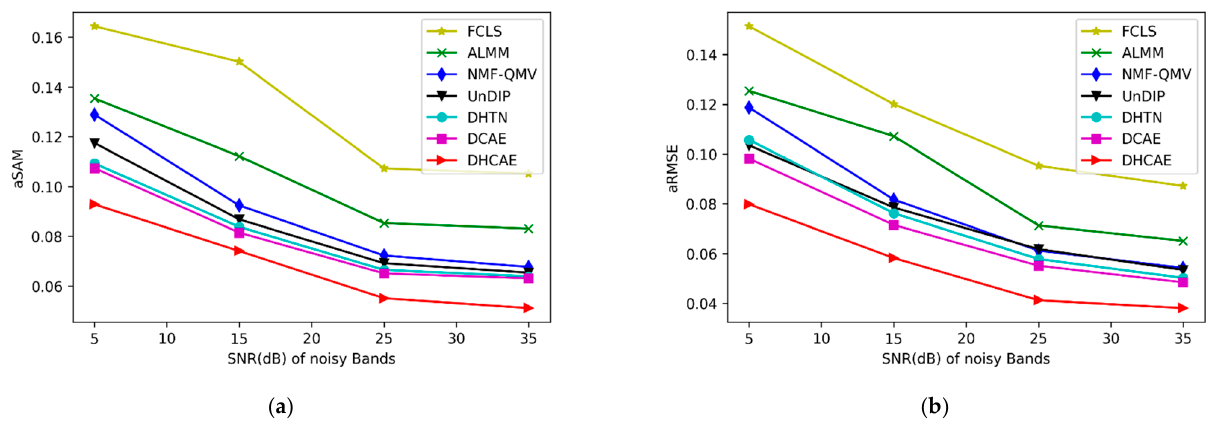
Figure 5. Robustness evaluation of the unmixing methods with various levels of band noise. ( a ) aSAM. ( b ) aRMSE.